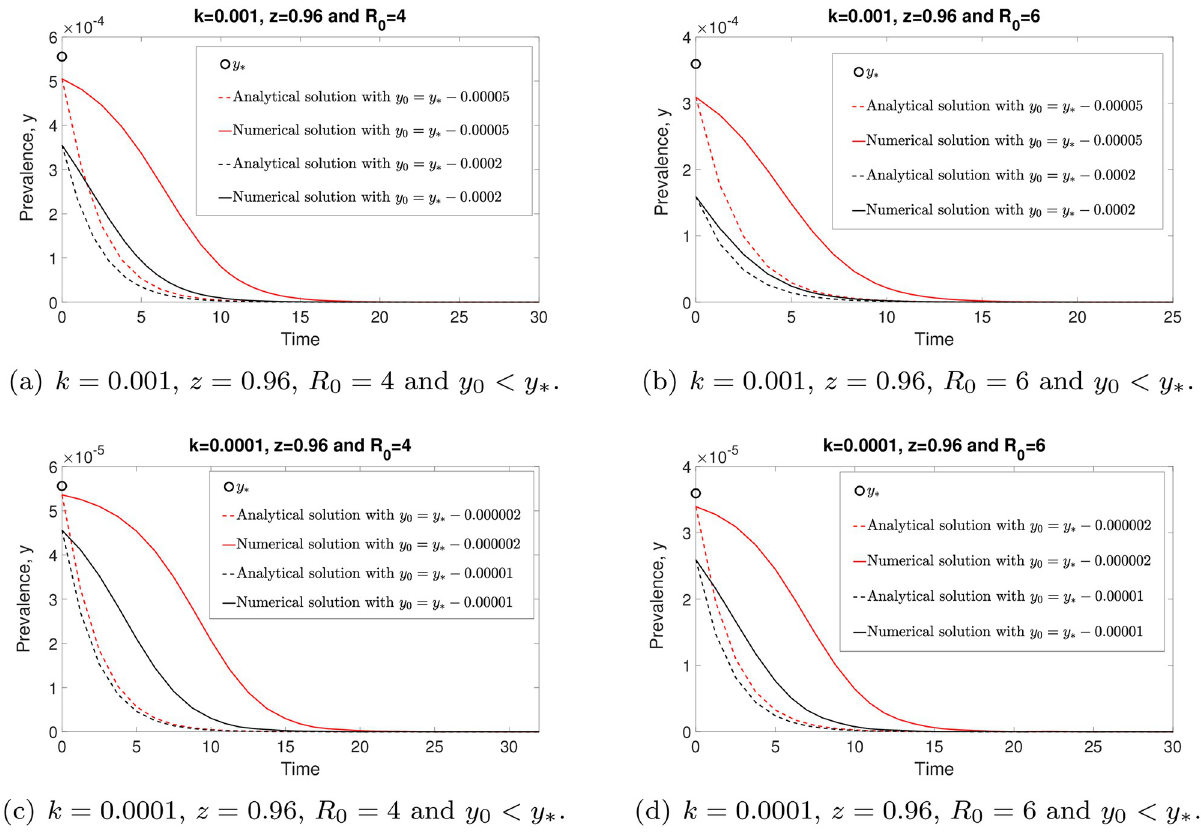
Fig 11. The comparison of the analytical solution (16) and the numerical solution of (5) around y = 0 as k ! 0. All solutions, both analytical and numerical, are eventually converging to zero whenever y 0 < y � . Hence disease elimination is possible in this case.